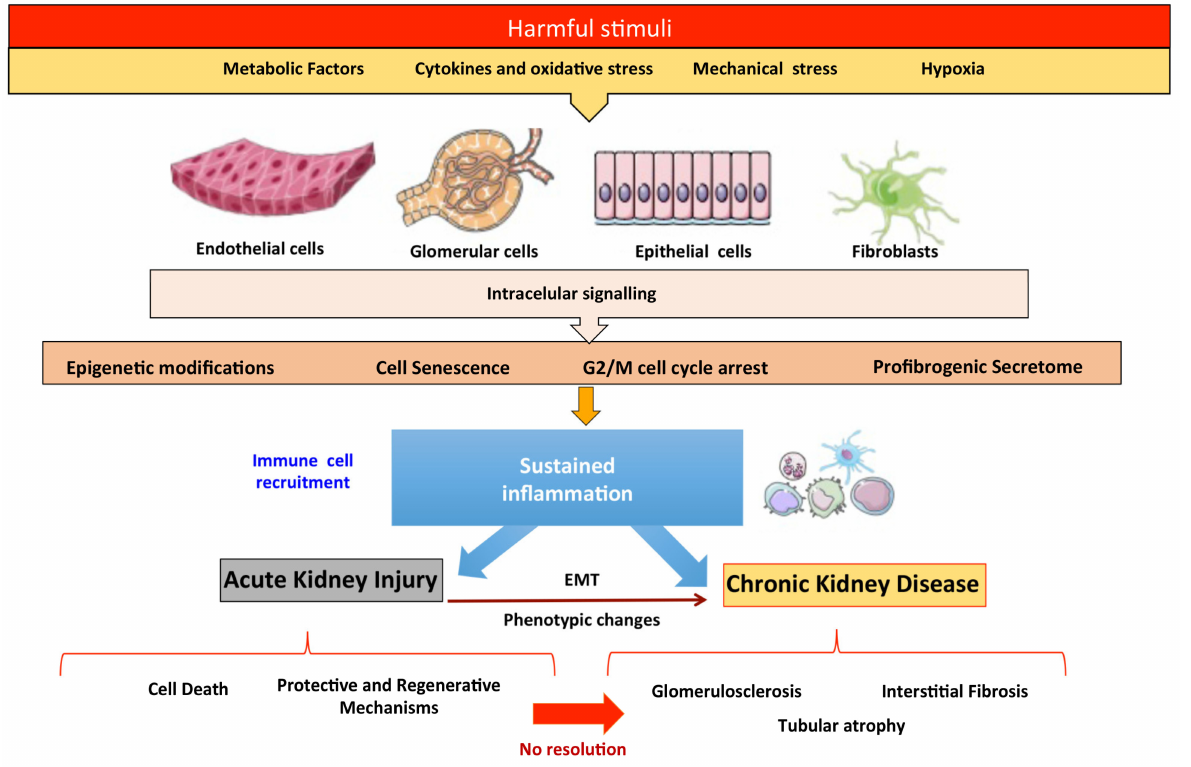
Figure 1. Mechanisms of kidney injury and